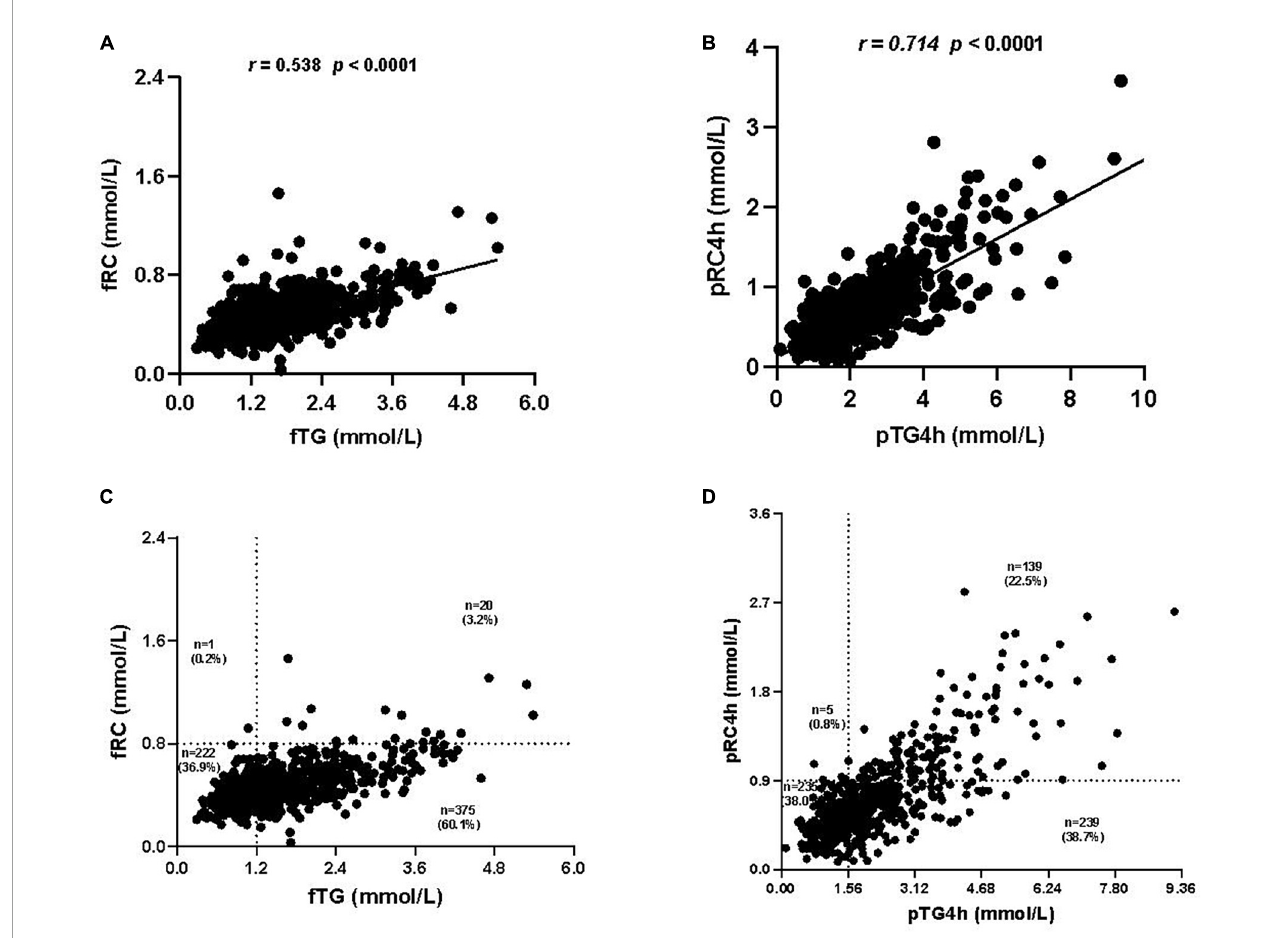
FIGURE3 Correlation analysis between the levels of triglyceride (TG) and remnant cholesterol (RC). (A) Correlation between fasting TG (fTG) and fasting RC (fRC) levels. (B) Correlation between postprandial TG level at 4h (pTG4h) and postprandial RC level at 4h (pRC4h). (C) Distribution of the fTG and fRC levels in all subjects. (D) Distribution of the pTG4h and pRC4h levels in all